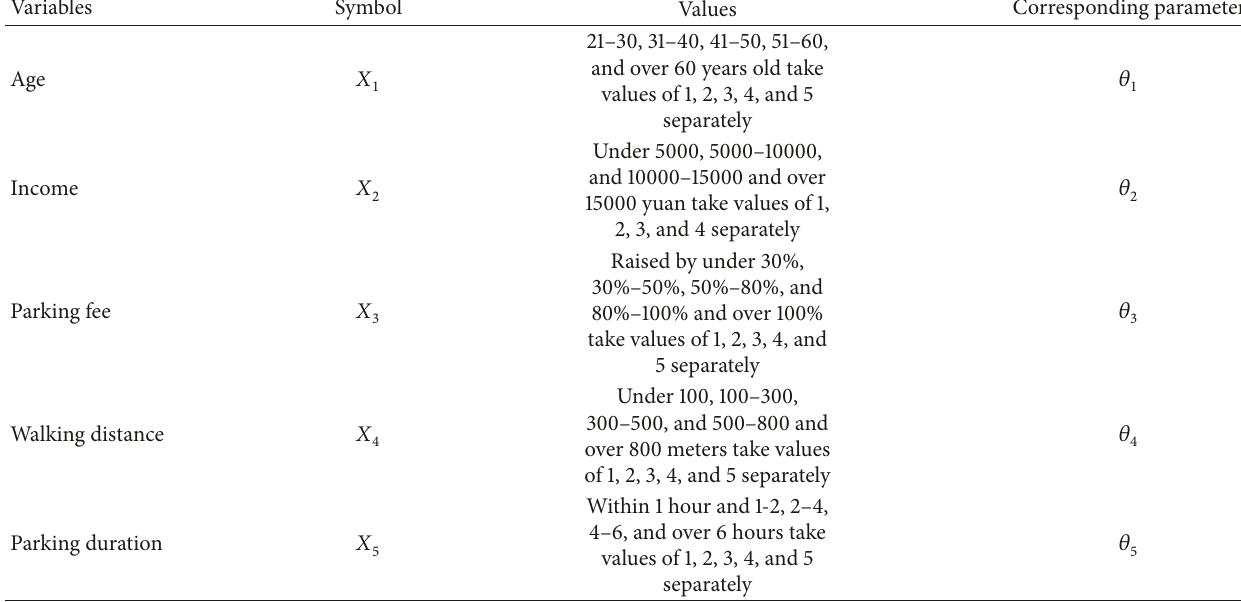
Table 3: Variables selected in the model construction.